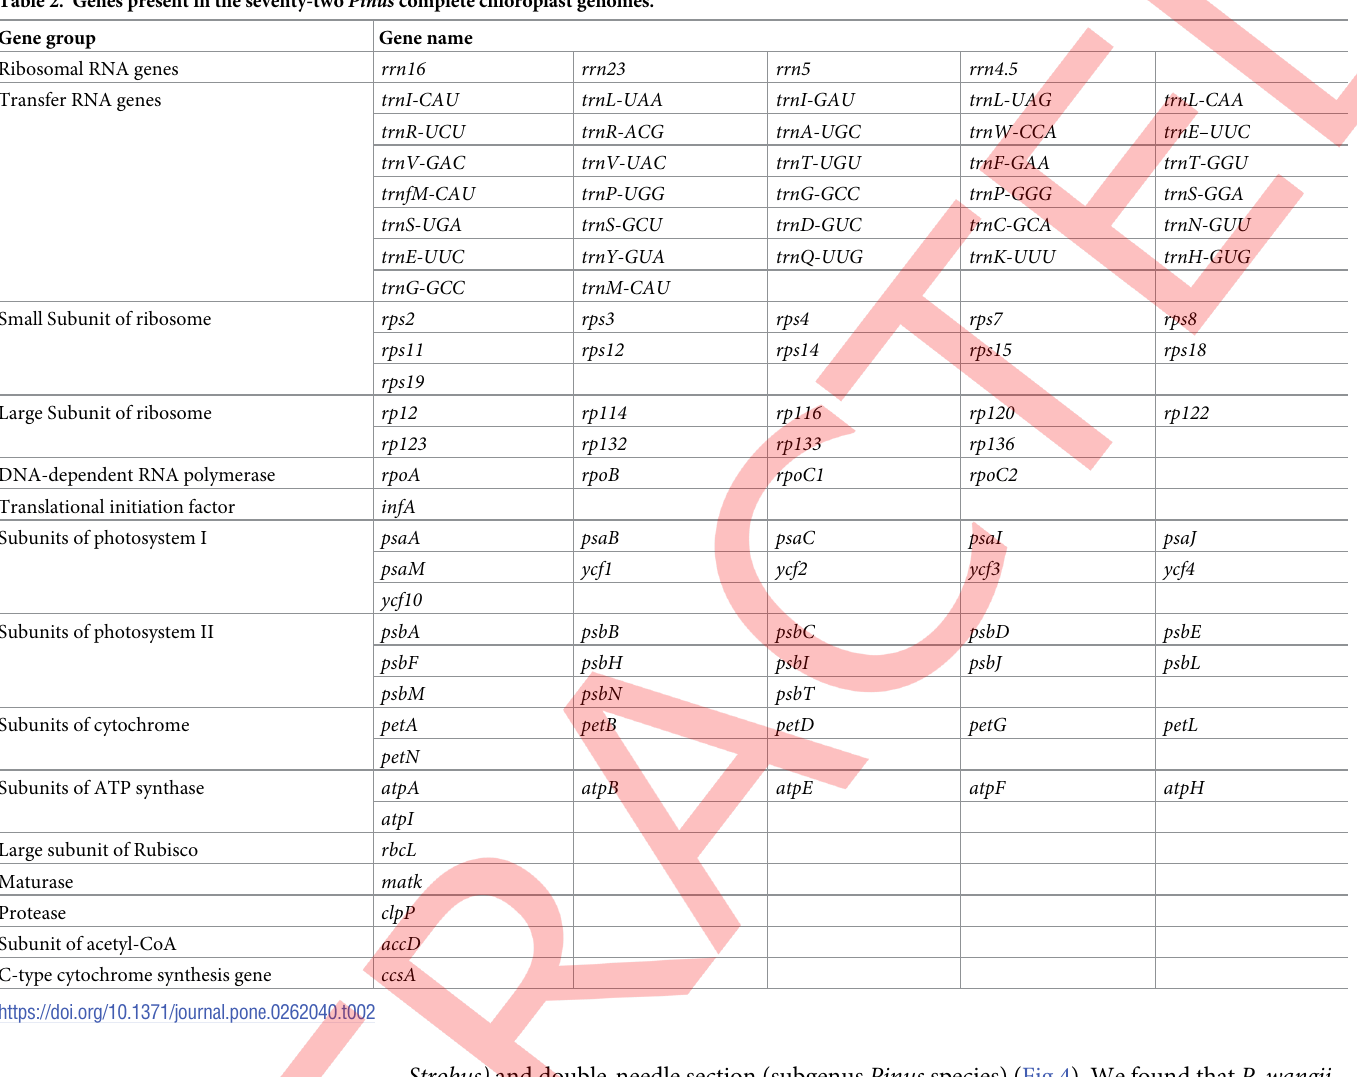
Table 2. Genes present in the seventy-two Pinus complete chloroplast